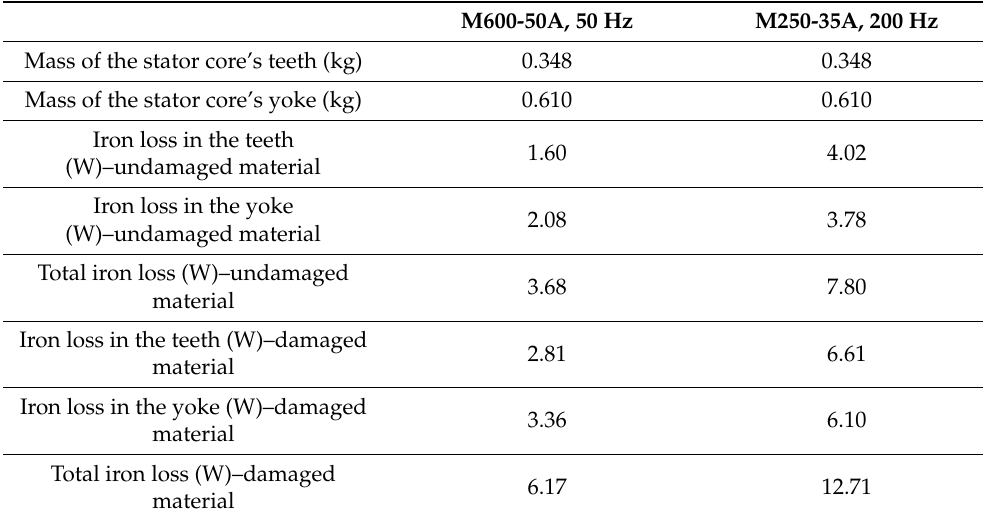
Table 3. The iron loss in the stator core estimated at 50 and 200